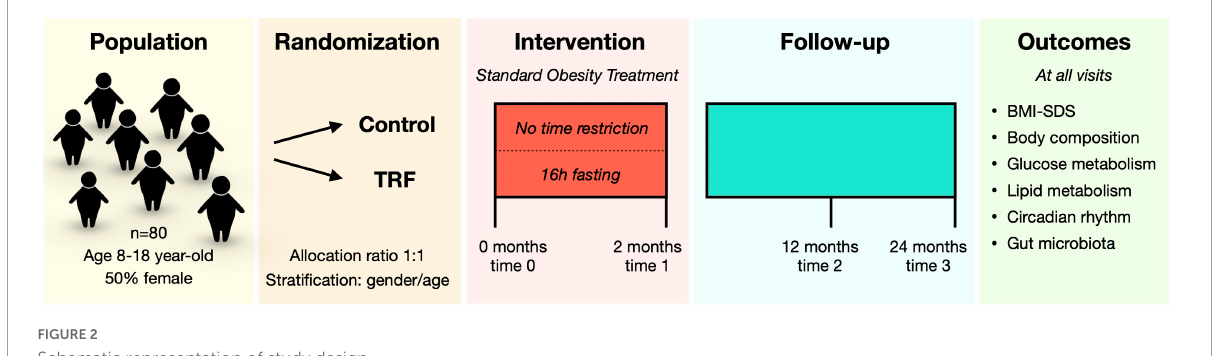
stadiometer and combined to calculate BMI-SDS based on the WHO growth charts. Participants will wear minimal clothing during the height and weight